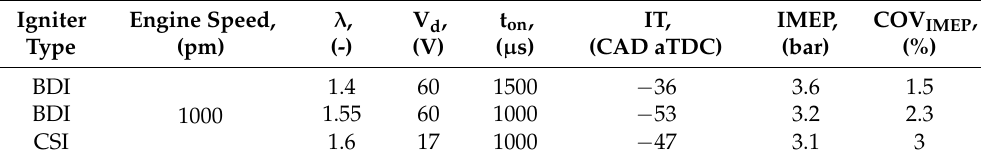
Table 4. Main technical characteristics of the experimental points of chosen to develop and test CNNs